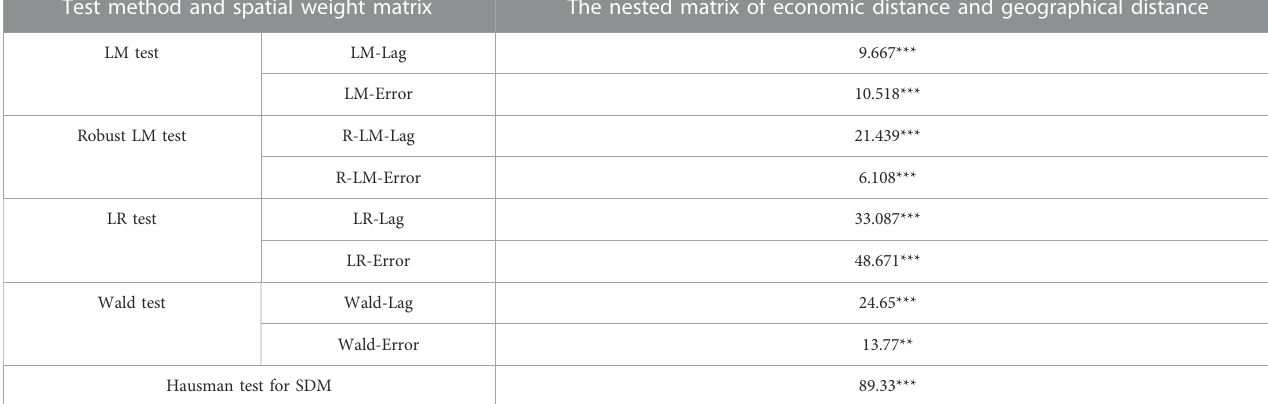
TABLE 7 Results of spatial regression optimal econometric model selection. Test method and spatial weight matrix The nested matrix of economic distance and geographical